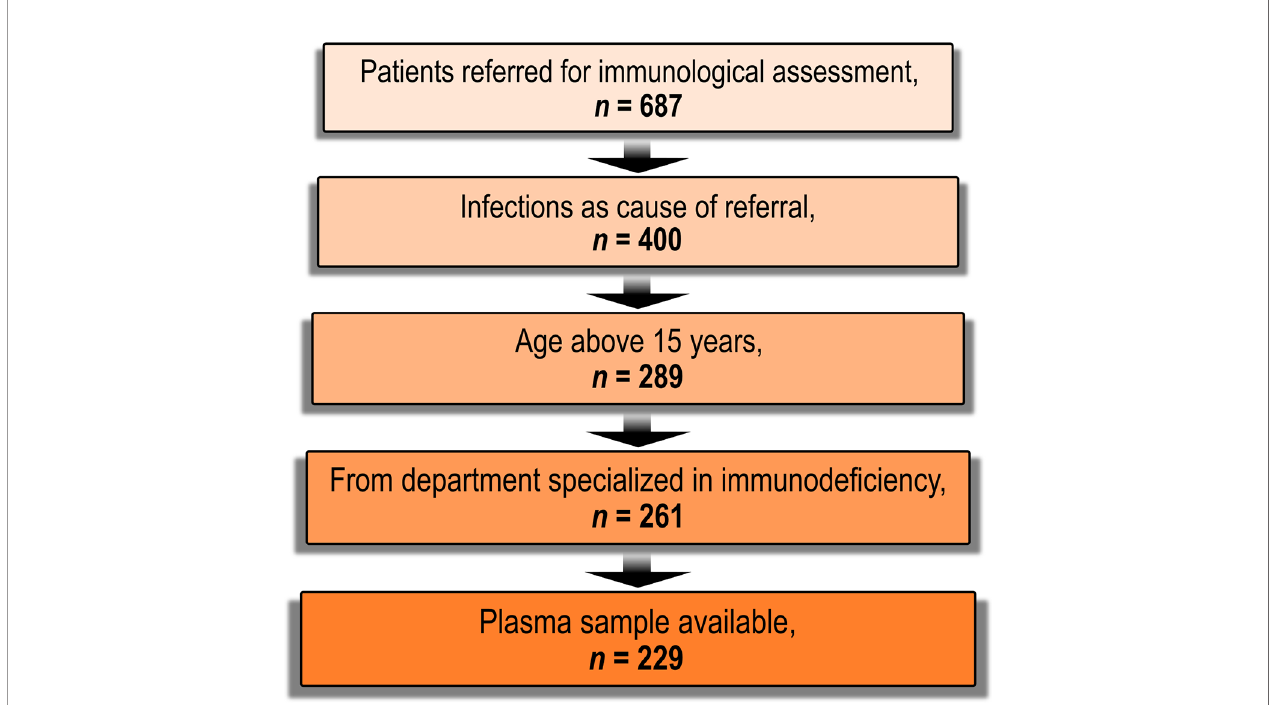
FIGURE 3 | Flow-chart of patient enrolment. Candidates eligible for inclusion were patients referred for advanced laboratory assessment of immunode fi ciency at the department of Clinical Immunology, Aarhus University Hospital, Denmark between 12 May, 2011 and 18 August, 2016 ( n = 687). Patients without an increased susceptibility to infections were excluded ( n = 287). Patients younger than 16 years were excluded ( n = 111) as diagnostic vaccination is not local practice in these patients. We also excluded patients who were referred from departments not specialized in immunode fi ciency ( n = 28). Patients without a previously archived plasma sample were also excluded ( n =